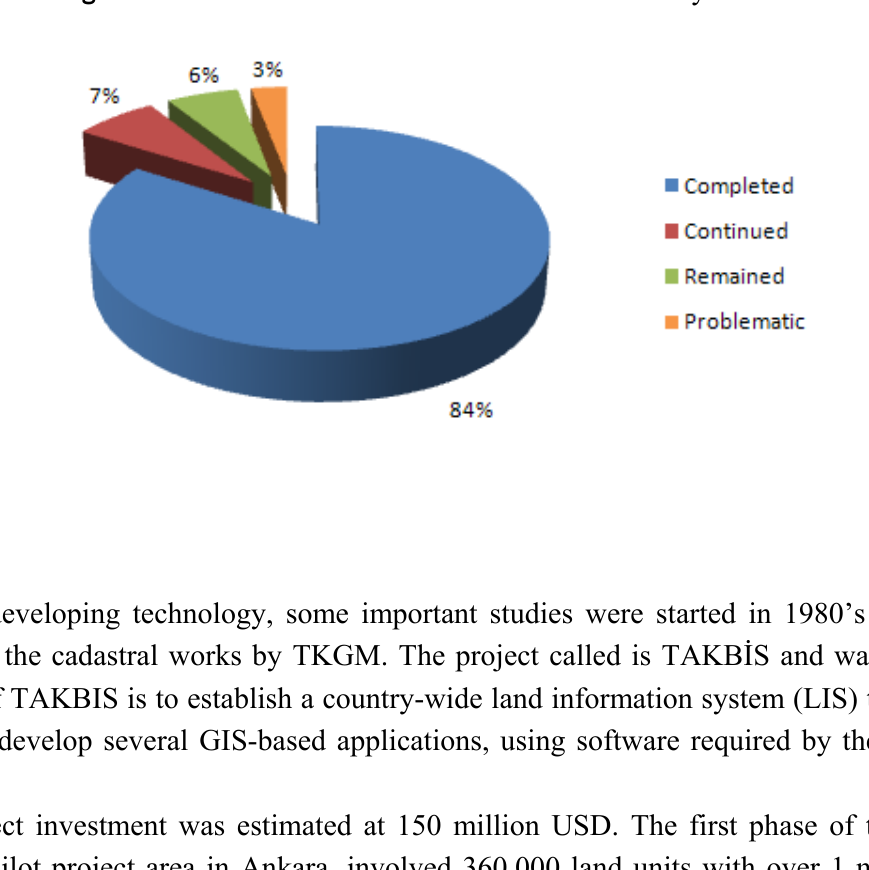
Figure 1. Latest situation of cadastre works in